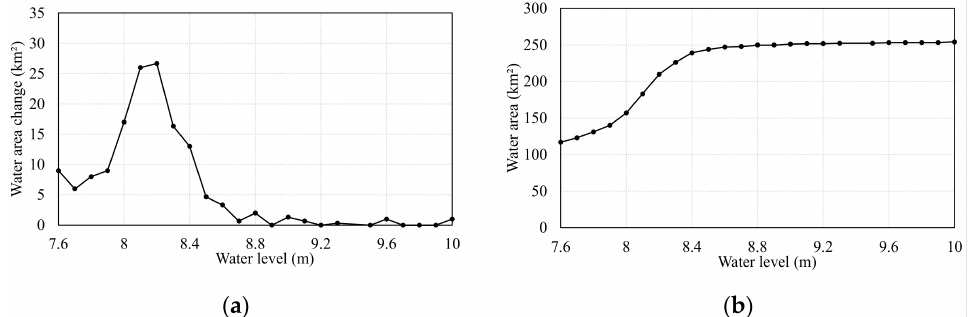
Figure 10. ( a ) Change of water area for every 0.1 m rise of water level. ( b ) Cumulative water area with water level in